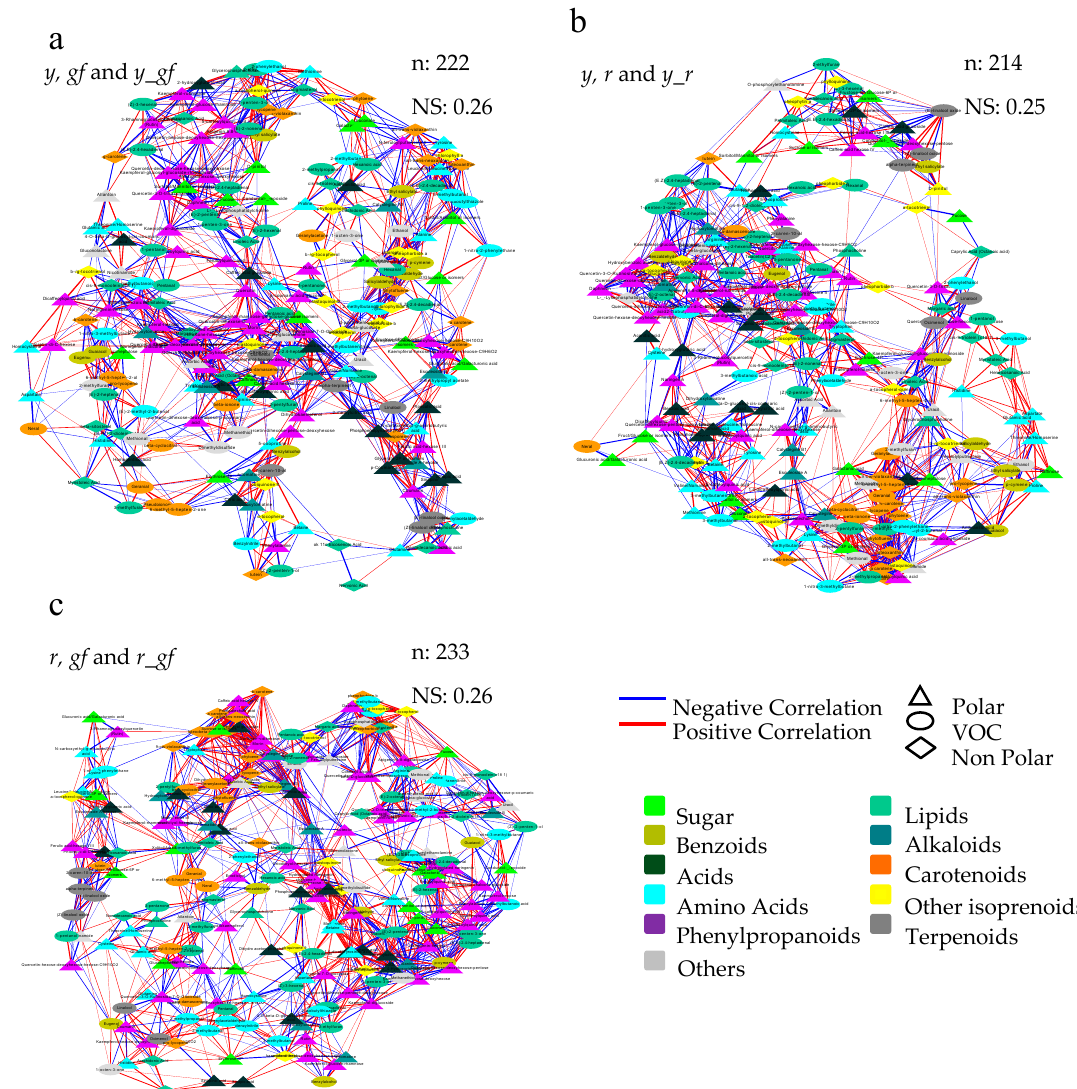
Figure 8. Correlation networks of metabolomics data in ( a ) y, gf and y_gf ; ( b ) y, r and y_r ; ( c ) r, gf and r_gf mutants. All the data from volatile (VOC), non-polar (NP) and polar (P) analyses were used as fold change to the San Marzano (SM) reference. Network topology was directed by the force of Pearson correlation coefficient index (Table S6). Each node represents VOC (turquoise circle), a NP (diamond) or a P (triangle) metabolite. Lines joining the nodes represent positive (red) or negative (blue) correlations. Node sizes are proportional to the respective node strengths, which are shown in Tables S7-S9. Node color is depending on the metabolic class of each compound as indicated in the figure. Number of nodes (n) and network strength (NS) are shown at the top of each network. Only correlations with ⏐ρ⏐ > 0.95 are shown ( p ≤ 0.05).